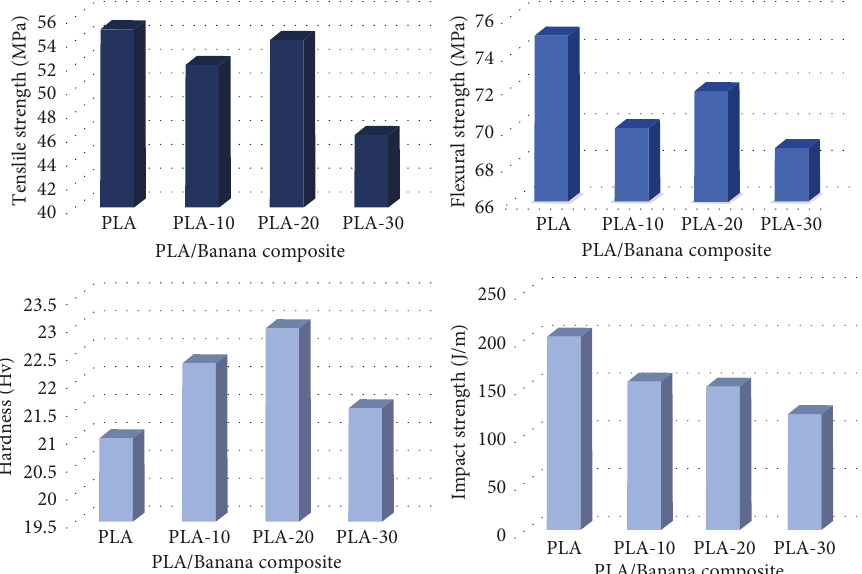
Figure 5: Mechanical properties of PLA/Banana fiber composites, with different contents: 10 wt.%, 20 wt.% and 30 wt.% Banana